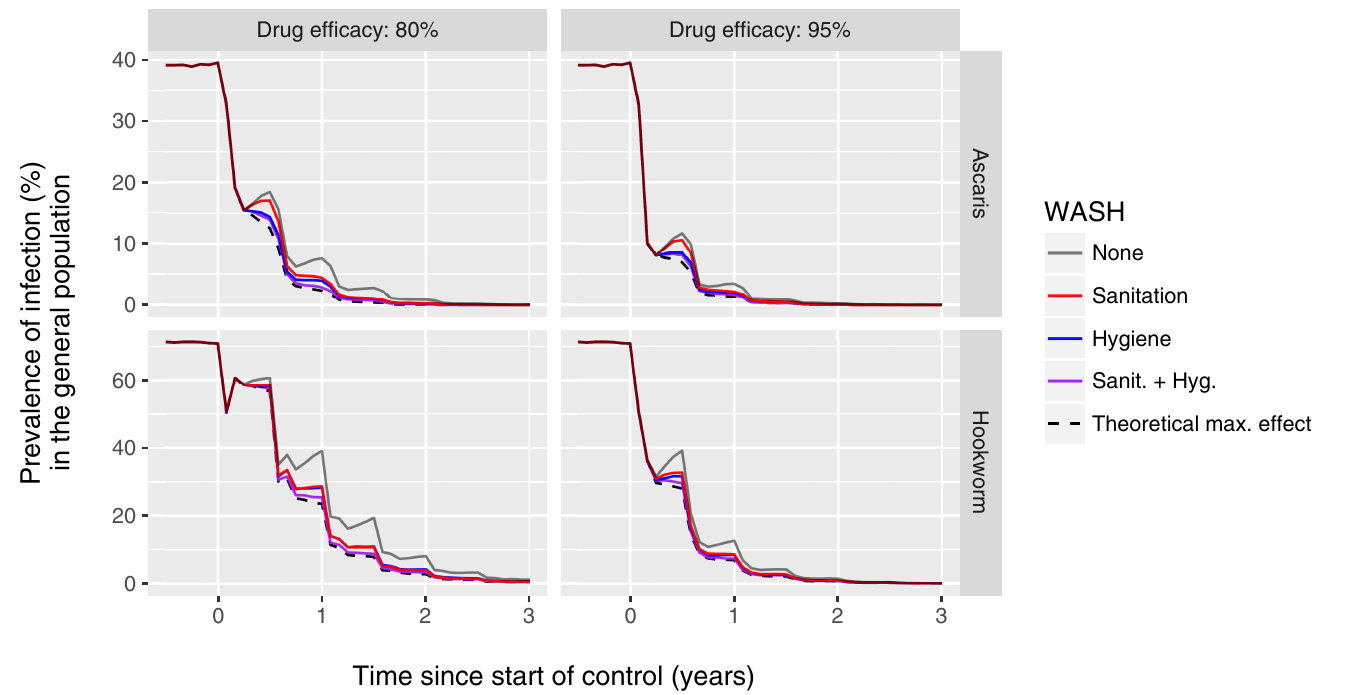
Fig 1. Model-predicted impact of community-wide WASH on prevalence of infection in the context of semi-annual community-wide preventive chemotherapy (PCT). The figure represents a setting highly endemic for A . lumbricoides and hookworm (rows of panels) where semi-annual community-wide deworming with is implemented at 80% population coverage. Drug treatment is assumed to kill either 95% or 80% of worms in treated individuals (columns of panels). Predicted prevalence of infection (y-axis) is based a single Kato-Katz faecal slide per individual. WASH interventions are assumed to be implemented at 70% uptake and 95% effectiveness. The dashed black line represents a theoretical scenario where sanitation and hygiene are perfectly implemented and taken up, reducing both exposure and contribution to transmission to zero for all individuals.